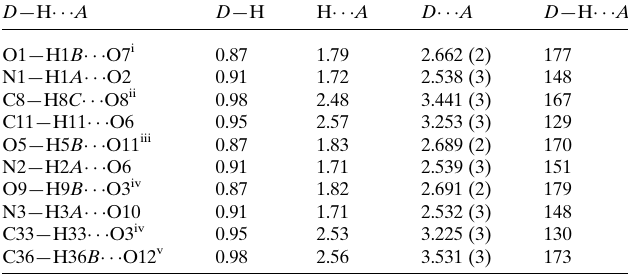
Table 1 Hydrogen-bond geometry (A˚ , (cid:4) ).